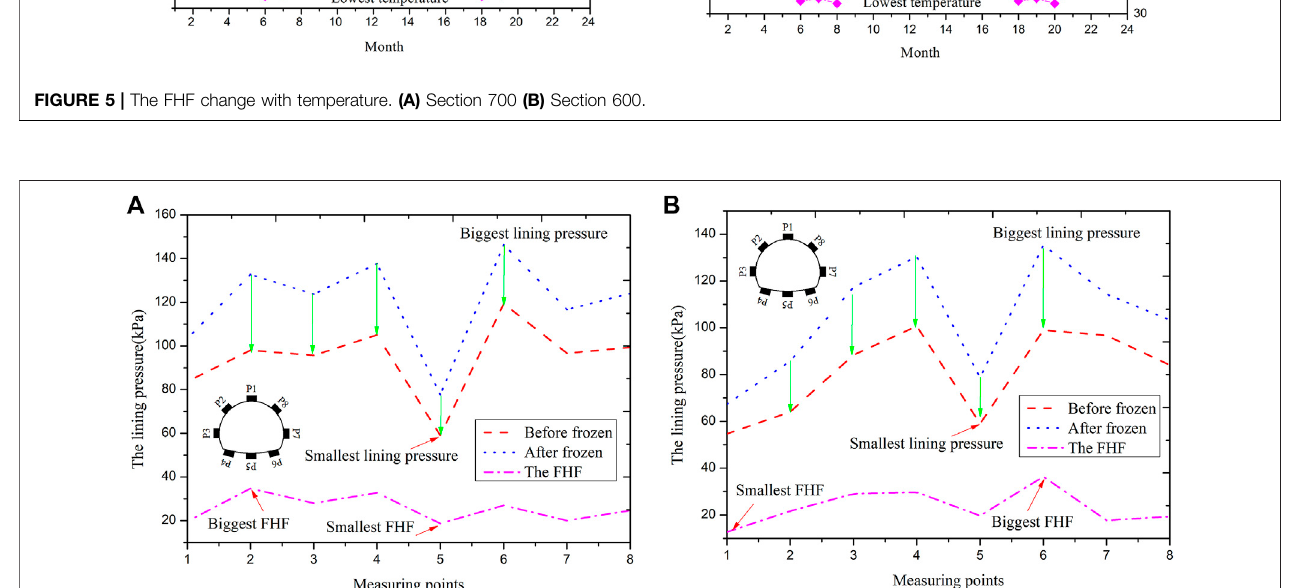
FIGURE 6 | Lining pressure comparison of frozen and unfrozen surrounding rock. (A) Section 700 (B) Section 600.